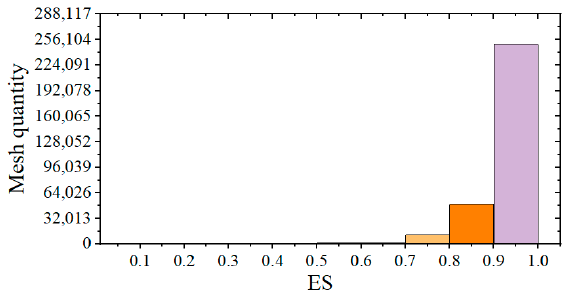
Figure 7. Comparison results of volumetric efficiency (VE) of different mesh models.